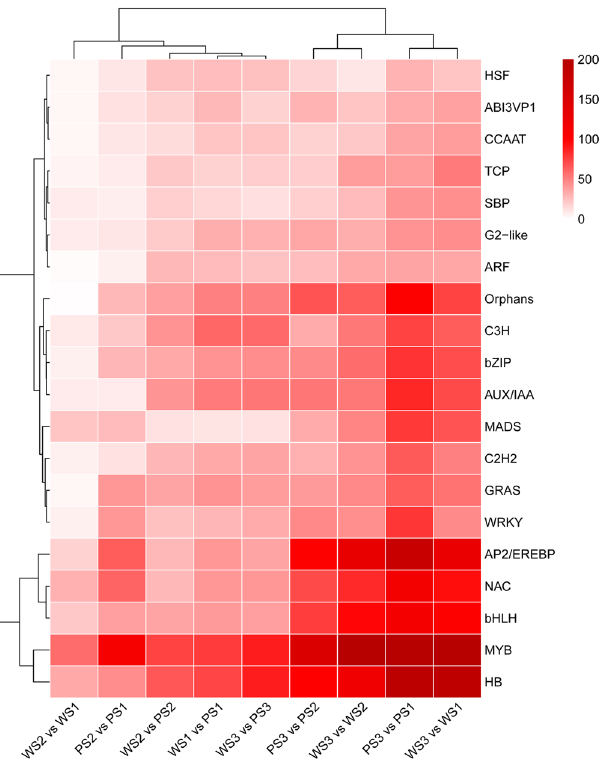
Figure 6. Cluster analysis of the top 20 transcription factor genes differentially expressed at three developmental stages of L. angustifolia spike in two cultivars. PS1, PS2, and PS3 indicate the purple lavender flowers at Bud I, Bud II, and flowering stage 50%, respectively. WS1, WS2, and WS3 indicate the white lavender flowers at Bud I, Bud II, and flowering stage 50%, respectively, and 1, 2, and 3 represent three independent biological